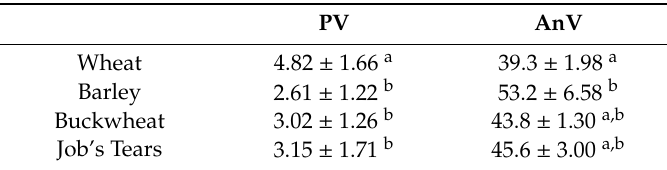
Table 1. Peroxide value (PV) and p -anisidin value (AnV) of oil after frying in the four flours examined in this study.